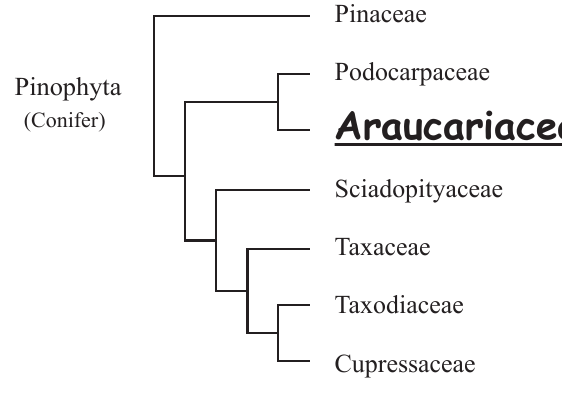
Fig. 1. Phylogenetic classification of